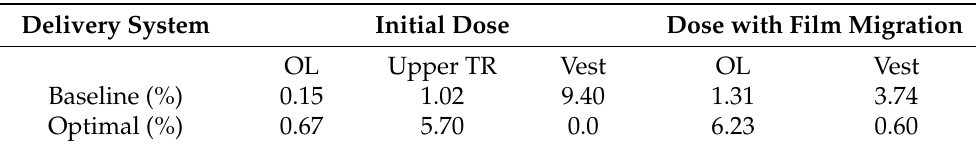
Table 2. Comparison of intranasal dose distributions between baseline and optimized delivery system before and after wall film migration.